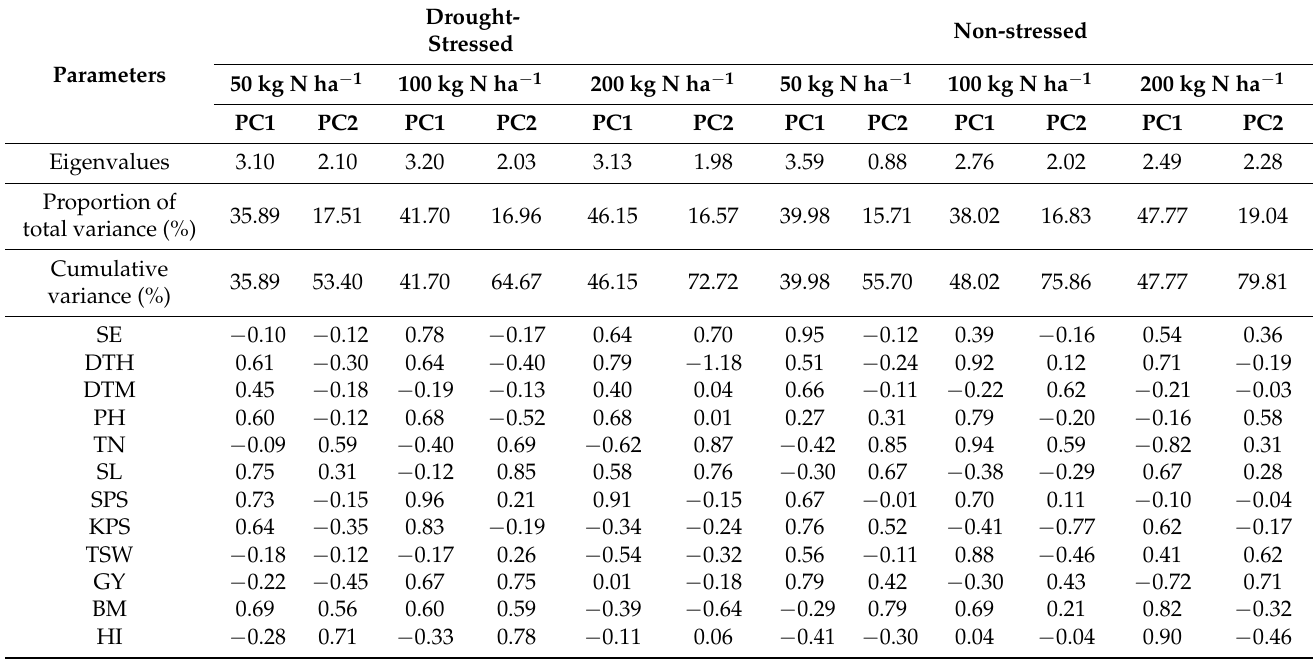
Table 7. Rotated component matrix of 12 phenotypic traits of 50 wheat genotypes evaluated in greenhouse and field conditions under drought-stressed (DS) and non-stressed (NS) conditions and three nitrogen